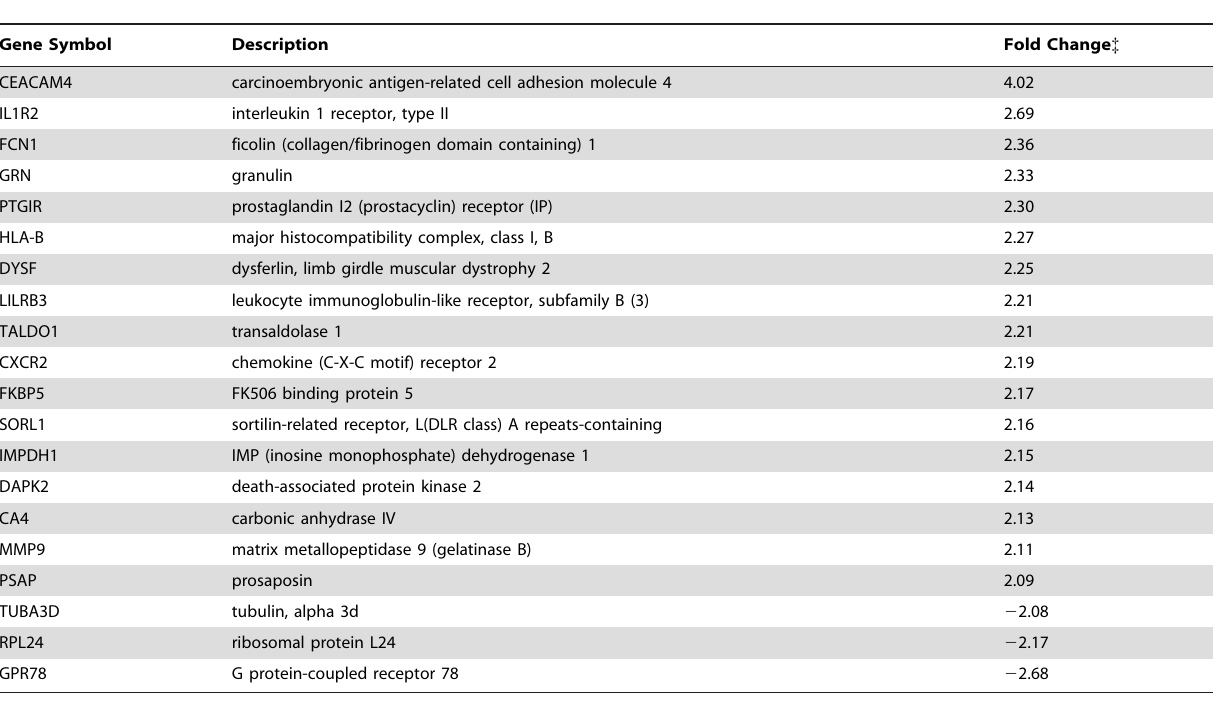
Table 3. Differentially-expressed genes that distinguish mild IPF from